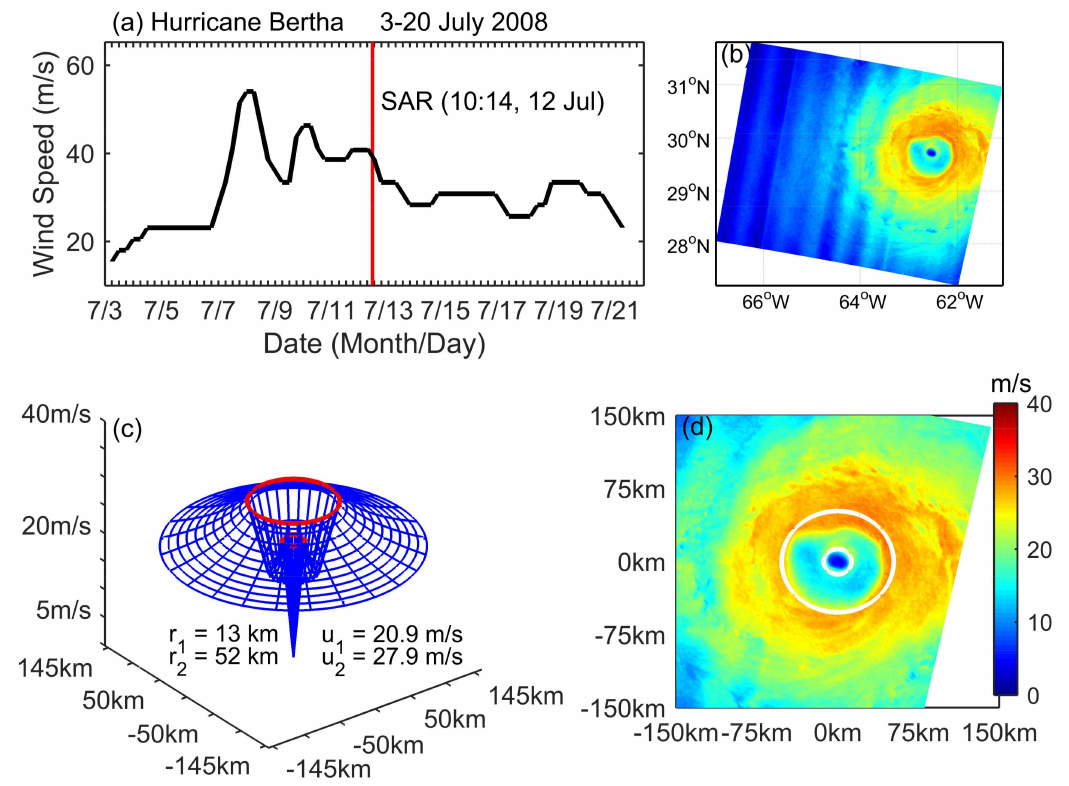
Figure 5. Hurricane Bertha (2008): ( a ) SAR captured time respective to the time series of Best Track Intensities; ( b ) retrieved sea surface wind speed from SAR images acquired at 10:14 UTC, 12 July 2008; ( c ) SHEW estimated closest idealized structure; and ( d ) storm-centered wind field of hurricane